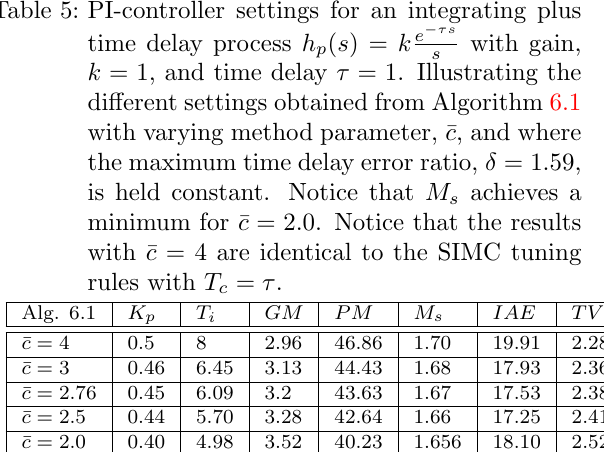
Table 5: PI-controller settings for an integrating plus